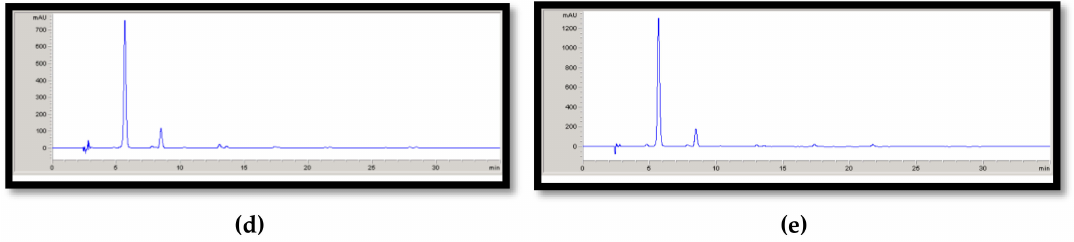
Figure 1. HPLC chromatograms for natural extract. ( a ) RA: Rosemary extract rich in Rosmarinic Acid, ( b ) NOS: Rosemary extract rich in diterpenes and NOVS: Rosemary extract rich in diterpenes and with lecitin as emulsifier, ( c ) P: Pomegranate extract, ( d ) HYT-F: Hydroxytyrosol extract obtained from olive fruit, ( e ) HYT-L: Hydroxytyrosol extract obtained from olive leaf.